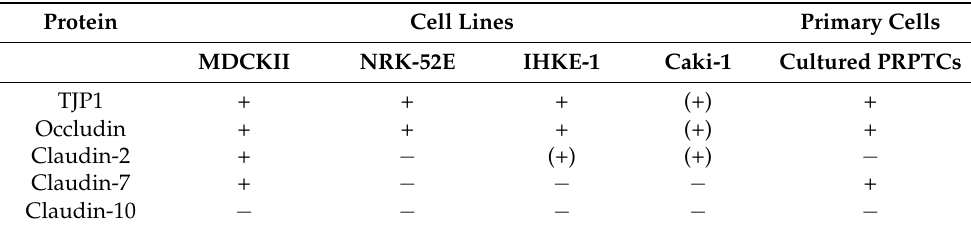
Figure 6. Relative mRNA expression of the tight junction proteins Tjp1 ( a ), Ocln ( b ), Cldn2 ( c ), Cldn7 ( d ) and Cldn10 ( e ) in freshly isolated and cultured PRPTCs. The mRNA expression of each gene was normalized to Gapdh expression and is shown in reference to the expression level of each gene in freshly isolated PRPTCs, which was set to 1. Each bar represents the mean ± SD ( n = 3), * p < 0.05, *** p < 0.001, ns = not statistically different ( p > 0.05). Table 2. Summary of expression levels of the investigated tight junction proteins in the renal cell lines MDCKII, NRK-52E, IHKE-1 and Caki-1, and in PRPTCs. Rating of the immunostainings was as follows: +, distinct signal at the cell–cell borders; (+), diffuse signal or signal predominantly in cytoplasm; − , no signal